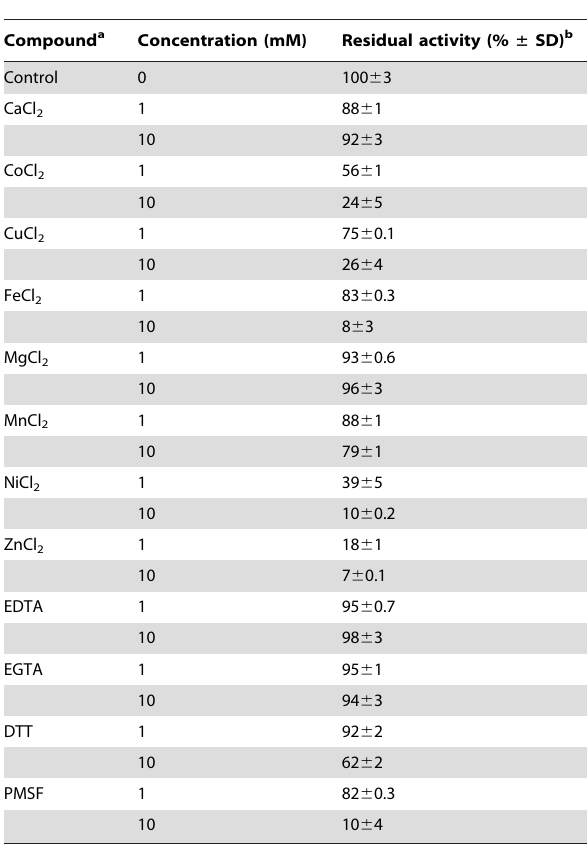
Table 1. Effect of metal and potent inhibitor concentrations on the activity of purified